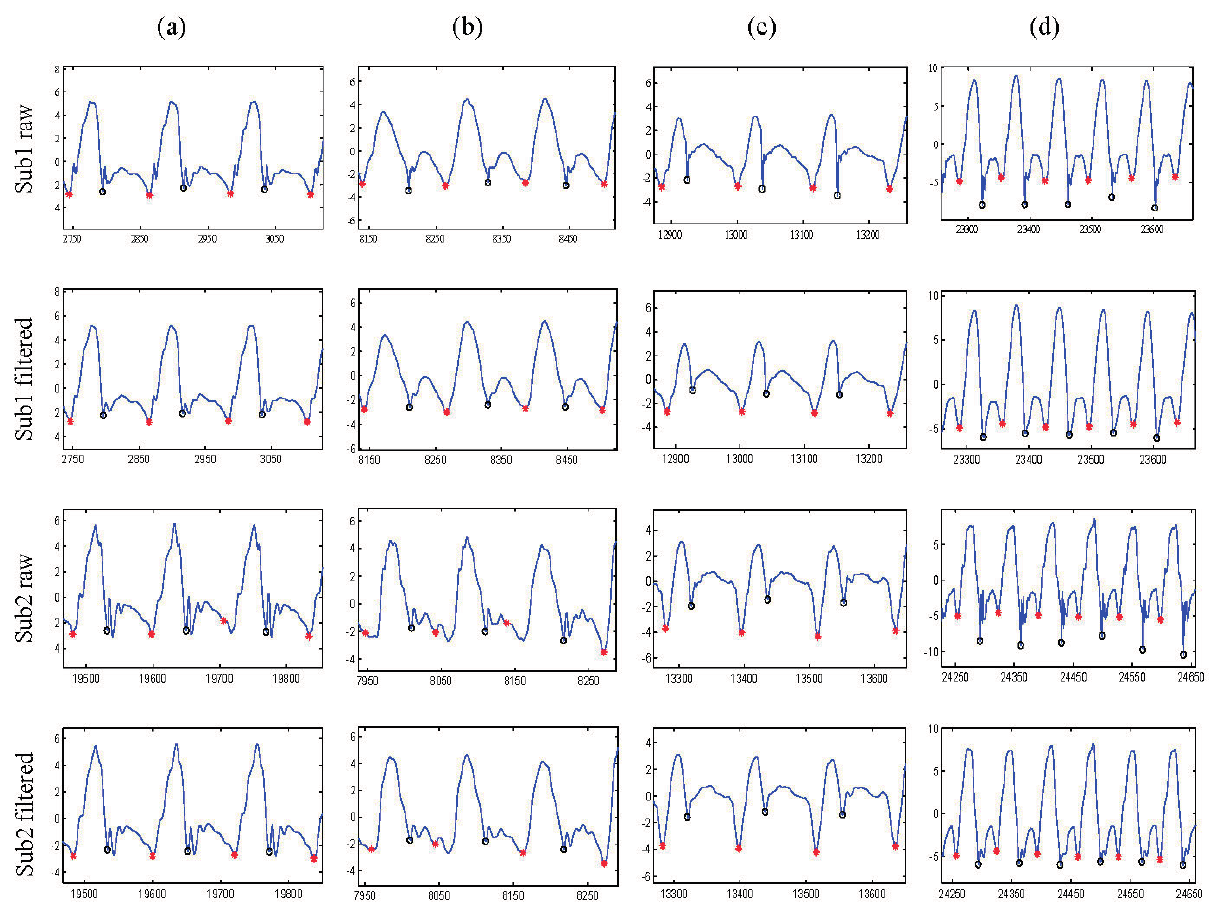
Figure 5. Signal segmentation based on gait events; zero circles are foot strike events, and red asterisks are foot-off events: ( a ) walking; ( b ) stairs descending; ( c ) stairs ascending; ( d )